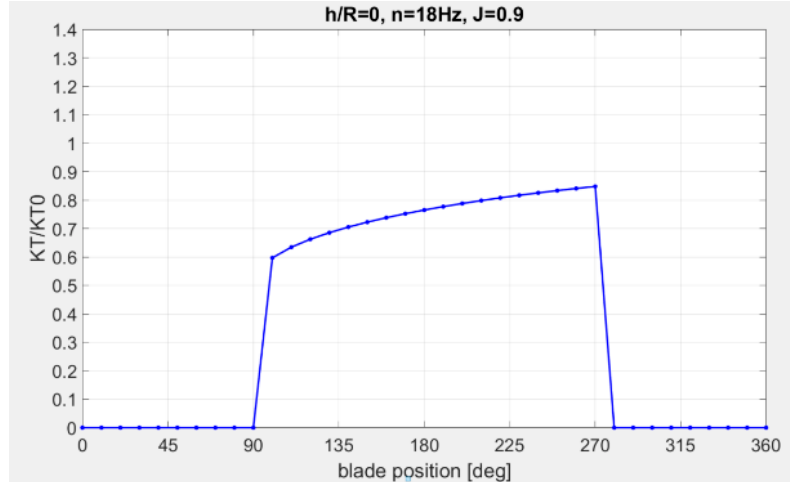
Figure 17. Thrust loss factor as a function of blade position, based on experimental results ( Koz10 ).